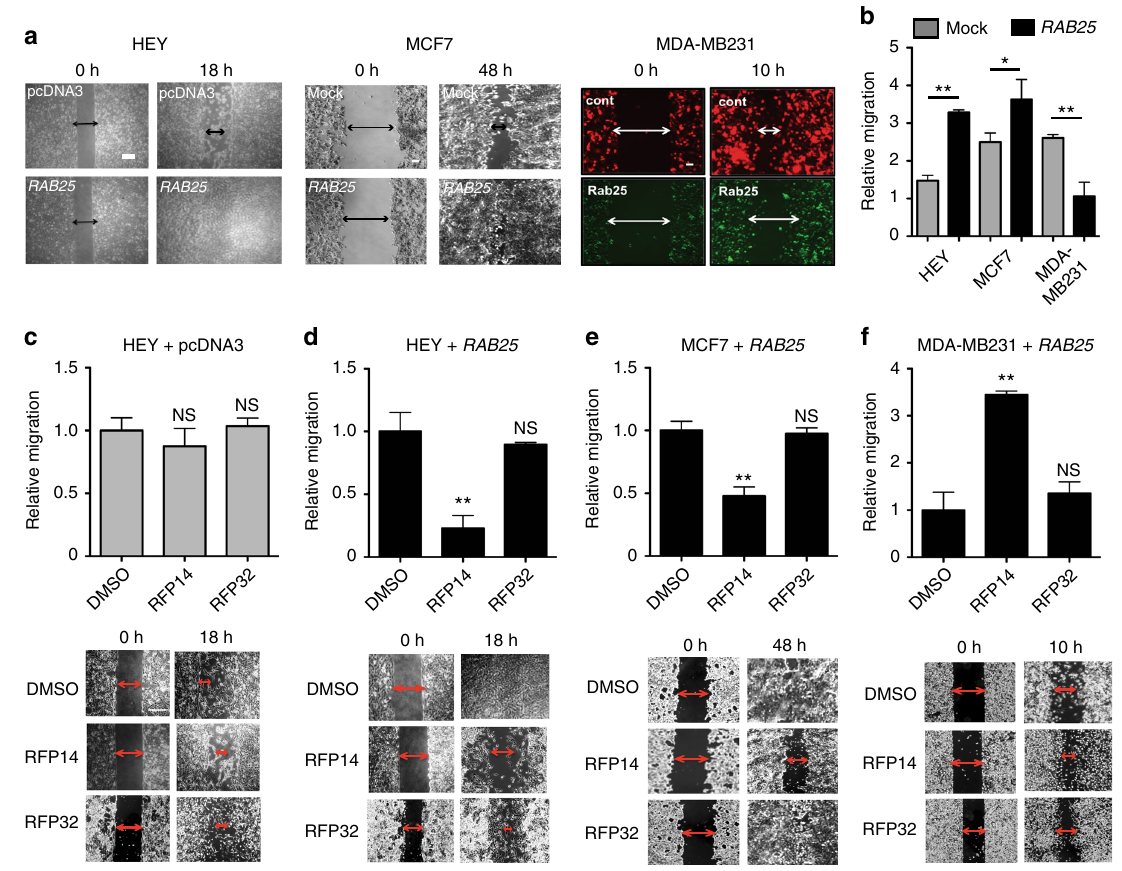
Fig. 5 RFP14 speci fi cally inhibits RAB25-dependent migration in cancer cells. a , b Representative time-dependent scratch-wound cell migration assay images a and quanti fi cation b of mock vector and RAB25 -expressing HEY, MCF7, and MDA-MB231 cells. RAB25 expression results in signi fi cant enhancement (HEY, MCF7) or inhibition (MDA-MB231) of cell migration. These data are representative of triplicate biological replicates. c , d RFP 14 (10 μ M) signi fi cantly impaired cell migration of RAB25 -expressing d , but not vector control c , HEY cells. e RFP14 (10 μ M), but not RFP32, signi fi cantly impaired cell migration of RAB25 -expressing MCF7 cells. f Treatment of RAB25 -expressing MDA-MB231 cells with RFP14, conversely, signi fi cantly increased cell migration relative to vehicle while the inactive control RFP32 remained unchanged compared to vehicle control. Representative scratch wound images are shown for RFP14, RFP32, and vehicle (DMSO) treatment conditions with overlaid arrows highlighting distance between cell fronts. Images and data shown represent mean ± s.e.m. of triplicate biological replicates. * P < 0.05; ** P < 0.01, Student ’ s t -test. NS, not signi fi cant. Inset scale bars for HEY cells in a = 250